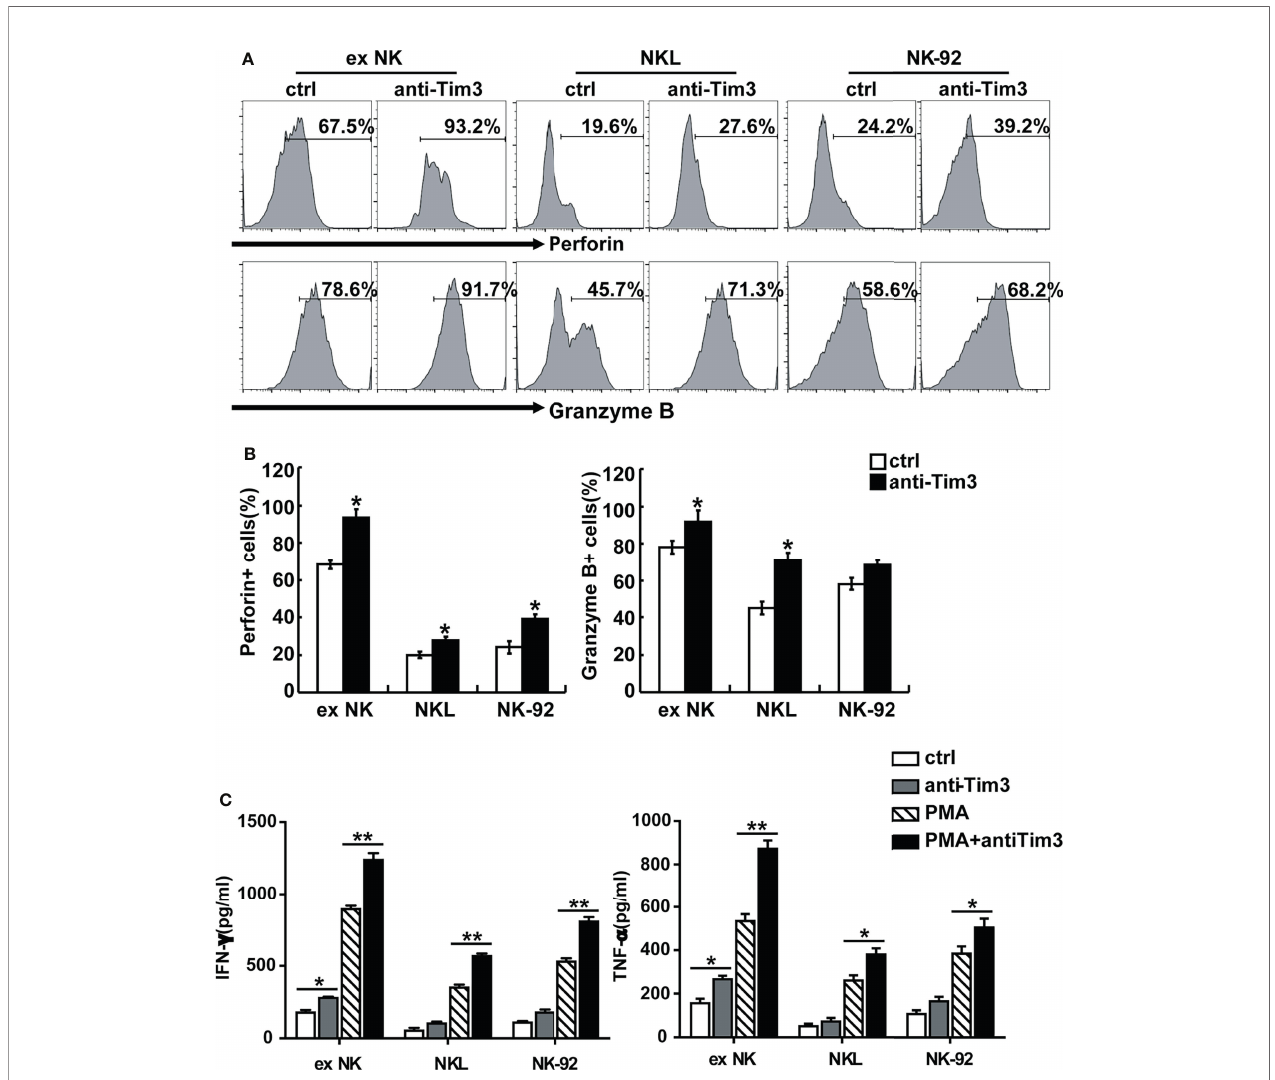
FIGURE 4 | Tim-3 blockade enhanced perforin and Granzyme B expression as well as cytokine secretion in NK cells. (A, B) exNK, NKL, NK-92 cells were pre- incubated with 10 m g/ml anti-Tim-3 or isotype antibodies for 48h. The protein levels of perforin and Granzyme B in NK cells were analyzed by fl ow cytometry. One representative of at least three independent experiments. Data shown were mean ± SD of at least three independent experiments. * P < 0.05, ** P < 0.01 versus control NK cells. (C) exNK, NKL, NK-92 cells were pre-incubated with 10 m g/ml anti-Tim-3 or isotype antibodies. Production of TNF- a and IFN- g by NK cells after stimulation with/no PMA/ionomycin for 48 h, as evaluated by ELISA assay. Data shown were mean ± SD of at least three independent experiments. * P < 0.05, ** P < 0.01 versus control NK